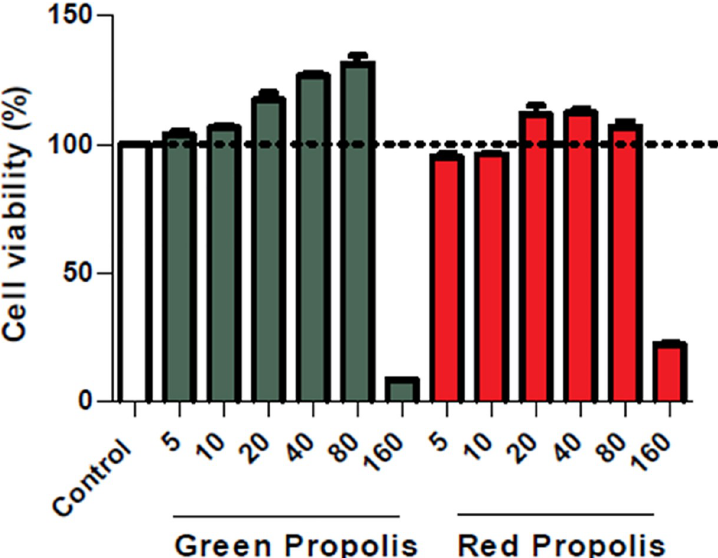
Fig 2. Cell cytotoxicity assessment by Alamar Blue. The data represents the viability of uninfected macrophages treated for 24 h with medium (Ctr) and the with the ethanolic extracts of propolis. The experiments were performed at least three times in quadruplicate for each experimental group. Data are shown as the mean +/- SD and are representative of three experiments.